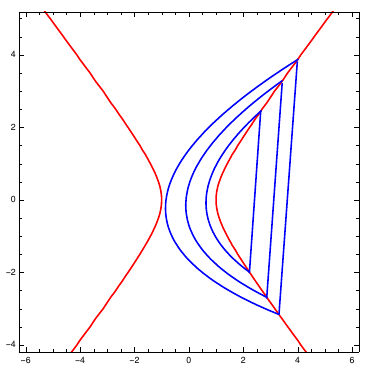
Figure 2. Three crossing limit cycles of PHS intersecting the hyperbola at two points.